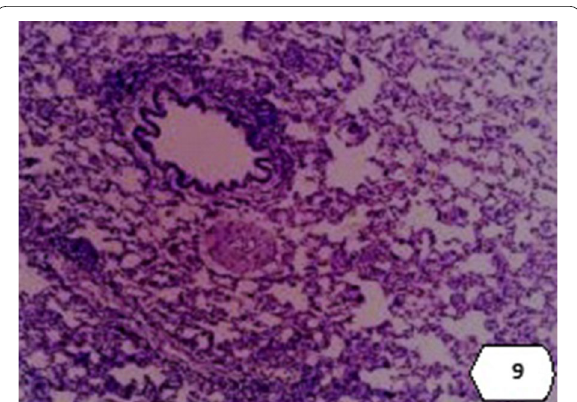
Fig. 9 Lung tissue image of normal control rats showing negative